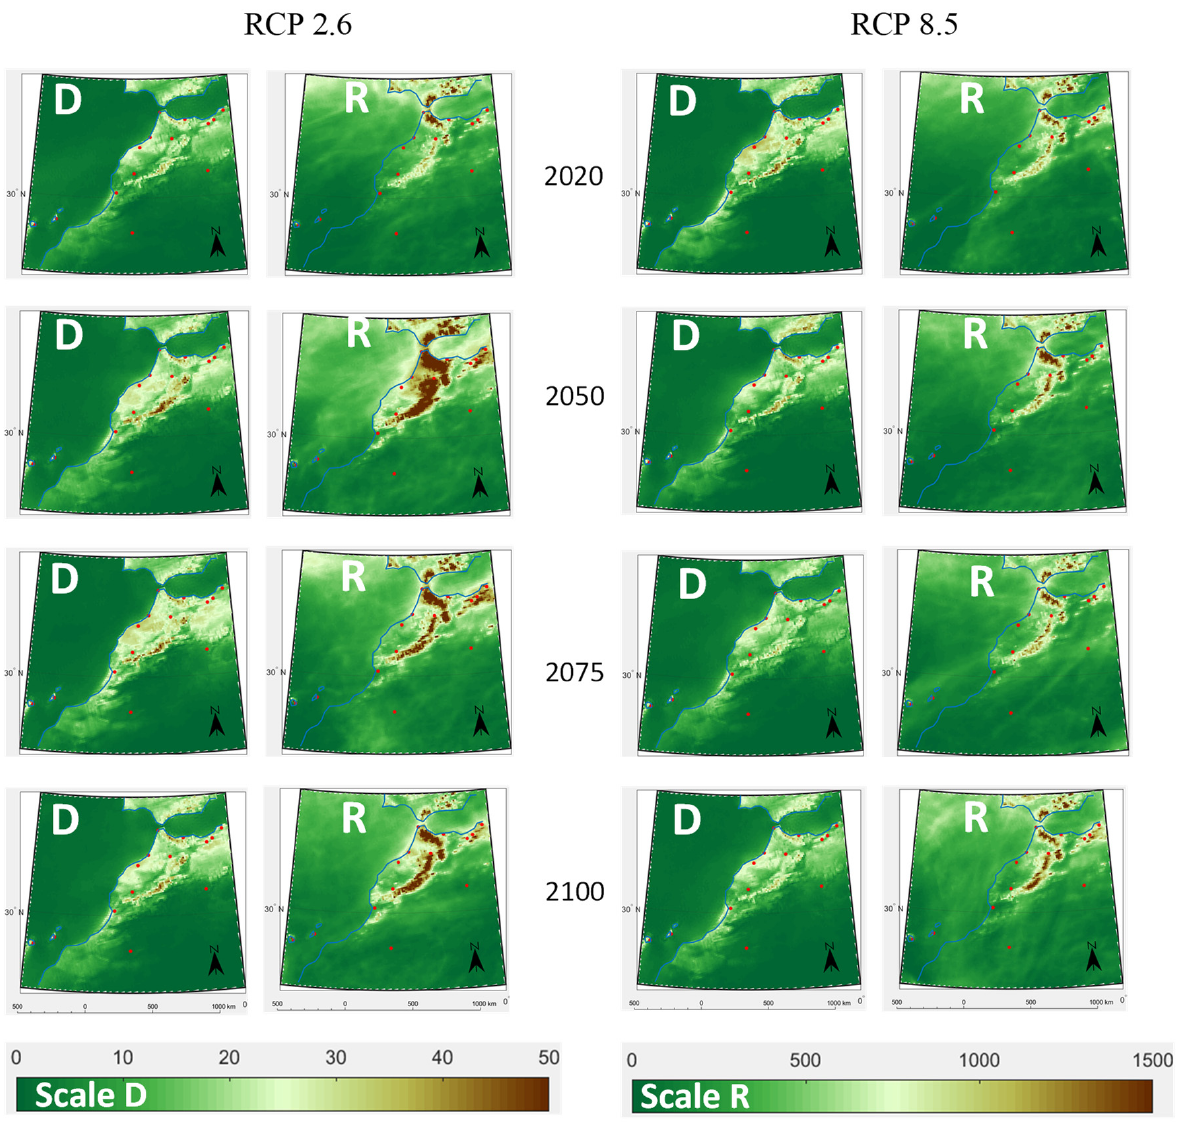
Figure 7. Projected yearly dew yields (D, mm·yr − 1 ) and rain yields (R, mm·yr − 1 ) in North-West Africa according to the RCP scenarios 2.6 ( left ) and 8.5 ( right ) for years 2020, 2050, 2075 and 2100 (from top to bottom). The red points are the airport stations described in Table 1 and Figure 1.